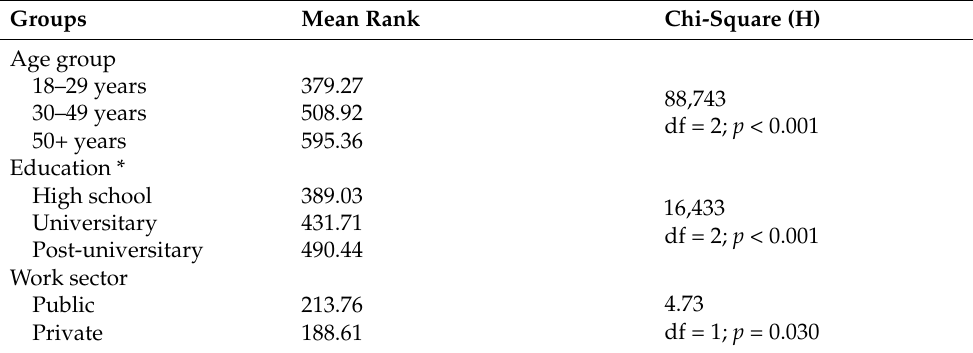
Table 4. Mean DN score and S.D. by age, level of education and work sector. Groups